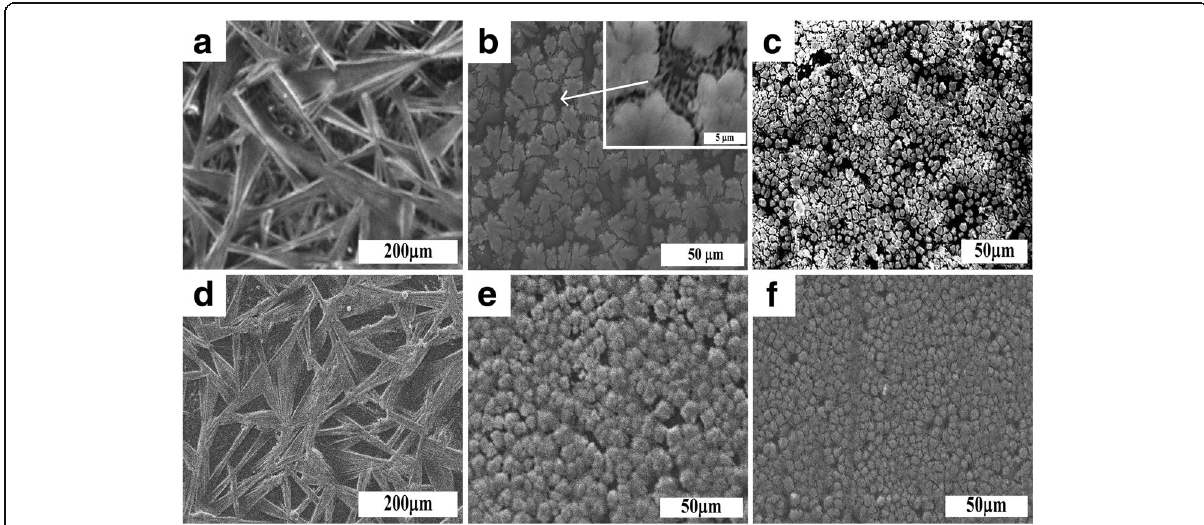
Fig. 3 Images of organic-inorganic perovskites films deposited on glass substrates ( a - c ) and FTO/glass ( d - f ). Inset in b — the enlarged image of the intergrain